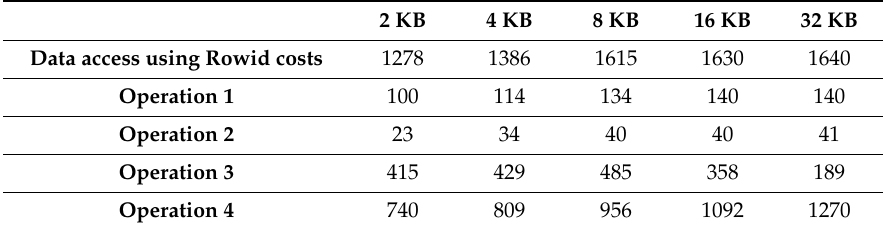
Table 7. Operation costs.